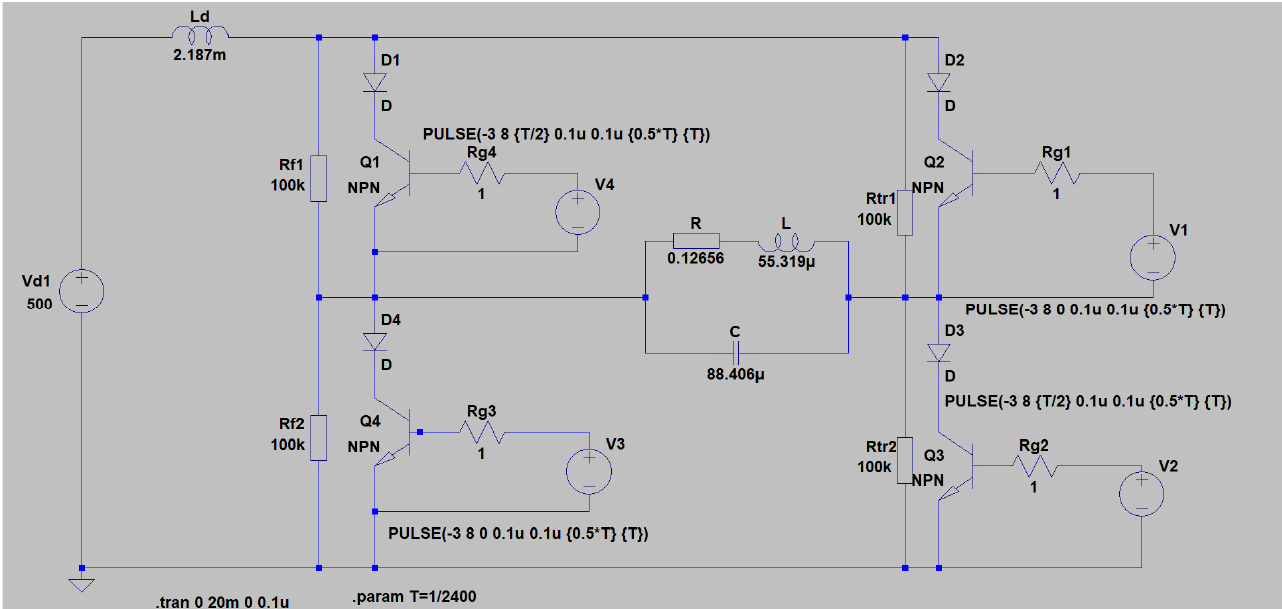
Figure A1. Simulation model of parallel current source inverter.